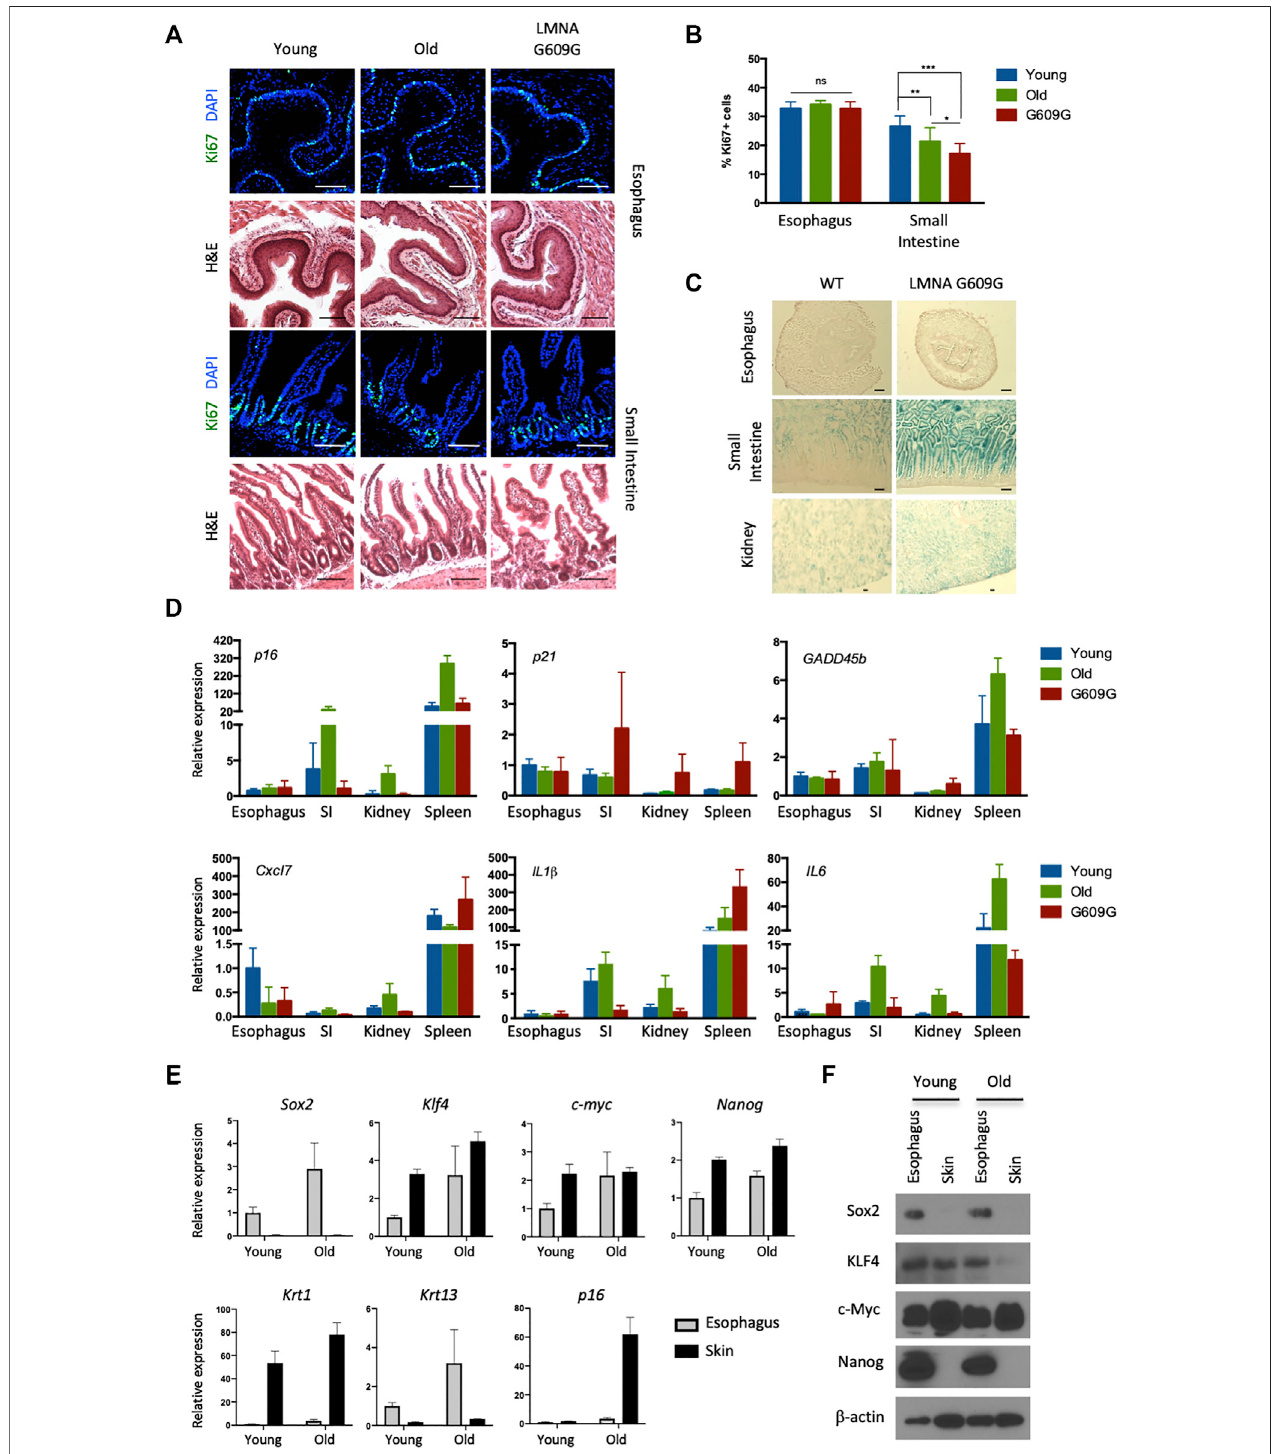
FIGURE 1 | No visible senescence of esophageal epithelial cells expressing pluripotency factors. (A) Representative immuno fl uorescent pictures of Ki67 (green) staining and H&E staining in the esophagus and small intestine for young (3 months old), old (22 months old) and LMNA G609G HGPS mouse model (3 months old). Scale bars, 100 μ m. (B) Proliferative index ofthe esophagus and small intestine. We quanti fi ed Ki67 + cells in the esophagus and small intestine from three mice for each group. Data represent the mean with SD. ns = non-signi fi cant, * p < 0.01, ** p < 0.001, *** p < 0.0001. (C) SA- β gal staining in the esophagus, small intestine and kidney for both young (3 months old) and LMNA G609G HGPS mouse models (3 months old). Scale bars, 100 μ m. (D) qPCR analysis for aging markers. SI: Small Intestine. Data represent the mean with SE ( n = 3). (E) qPCR analysis for the esophagus and the skin from young and old mice. Krt1 and krt13 were used as speci fi c keratins for the skin and the esophagus, respectively. Datarepresent the mean with SE ( n = 3). (F) Western blotting for pluripotency factors. Epithelial cells were isolated from the indicated tissues and cultured for 1 week before cell lysate preparation. Frontiers in Cell and Developmental Biology |